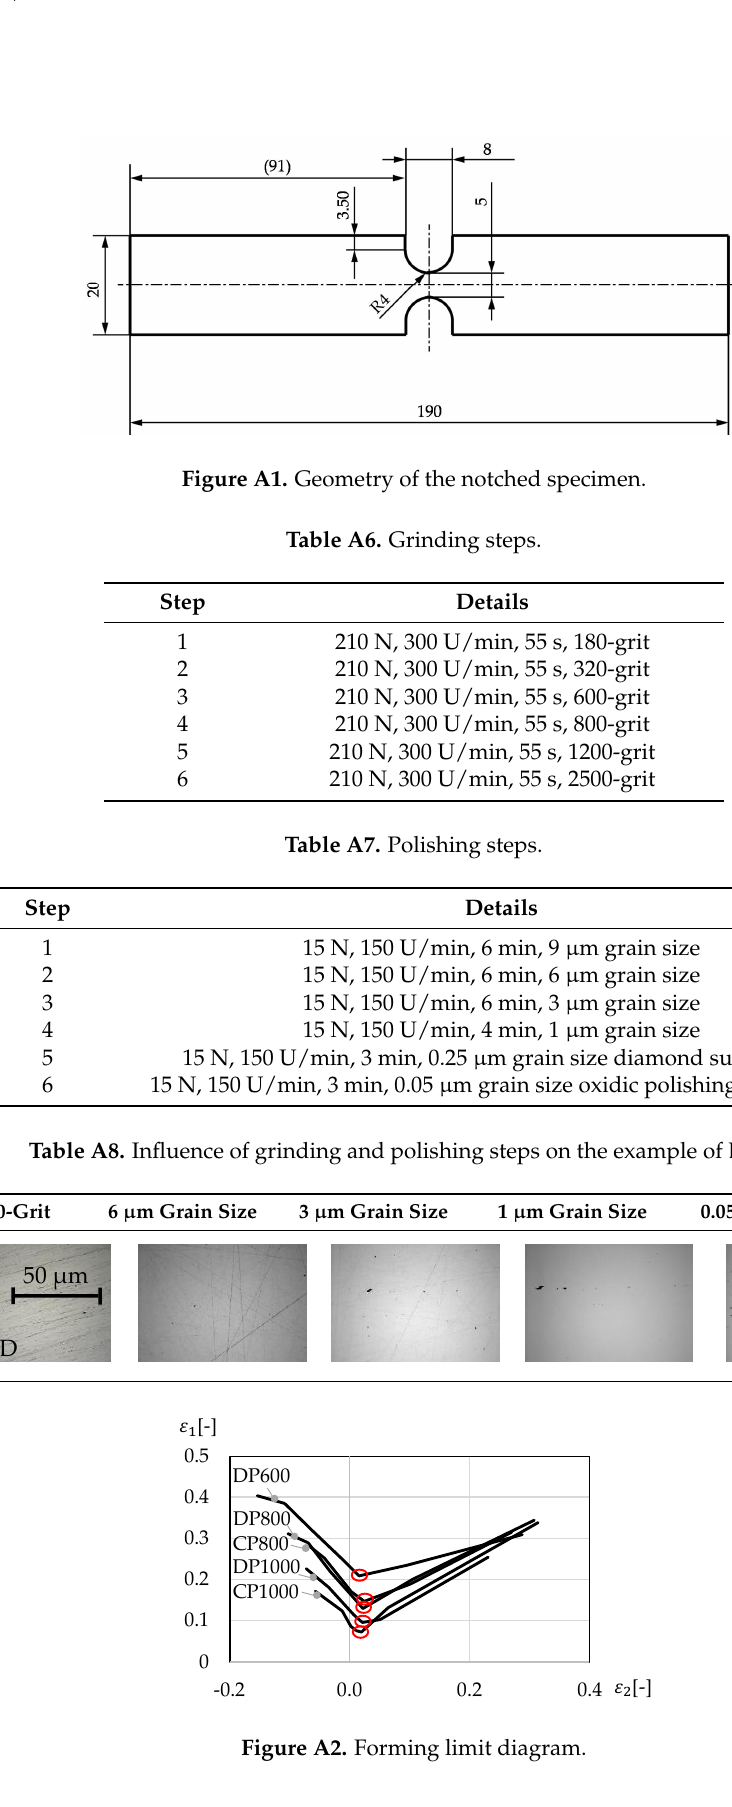
Figure A3. Initial blank geometry for cross-die samples. Table A9. Drawing depths without failure (necking or fracture) of cross-die samples. Setting 100 kN Table A10. Ductile fracture of cross-die samples. D P 600 D P 800